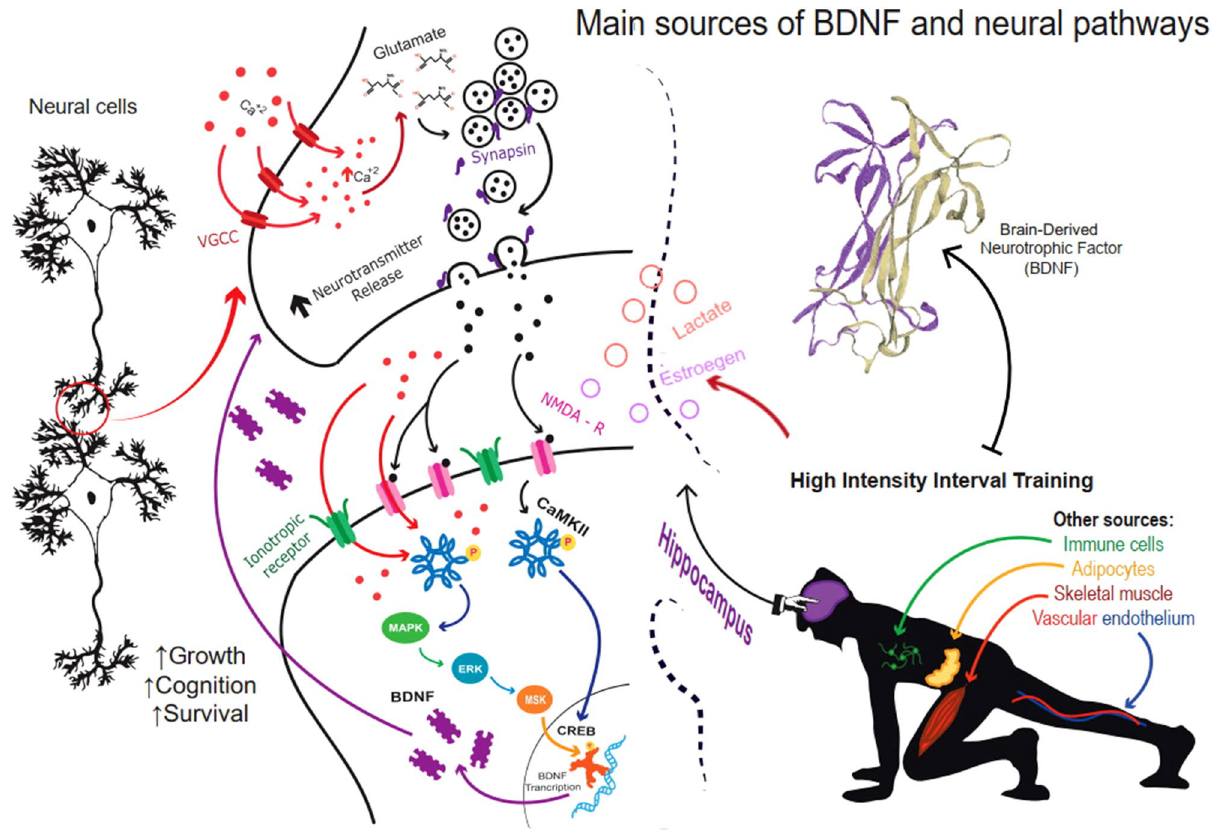
Figure 5. Interval training increases circulating BDNF levels in healthy adults (upper right). During this response, the brain (hippocampal region) seems be the main BDNF source; nevertheless, other tissues function as BDNF synthesizers. The mechanism of activation during IT has not elucidated yet (above right). In brain, BDNF synthesis is activated by an increase of calcium (Ca2+) concentrations in the cytosol. Inside neurons, Ca2+ activates calmodulin dependent kinase II (CaMKII), triggering activation of the MAPK/ERK/MSK cascade resulting in an increase in the expression and phosphorylation of cAMP response element-binding protein (CREB). CREB initiates BDNF transcription resulting in increased BDNF synthesis and release (left). Once secreted, the neurotrophin regulates molecular mechanisms associated with neuronal growth, cognition, and neuron survival (above left). Finally, scientific evidence suggests that other circulating molecules such as lactate and estrogen enhance BDNF synthesis in brain (center). The putative mechanism indicate that lactate increases calcium current in the neurons, and estrogens activates nuclear estrogen receptors and membrane estrogen receptors that enhance the BDNF synthesis. Figure made with adobe illustrator cs6. https:// www. adobe. com/ produ cts/ illus trator/ free- trial- downl oad. html. Figure conceived and designed for